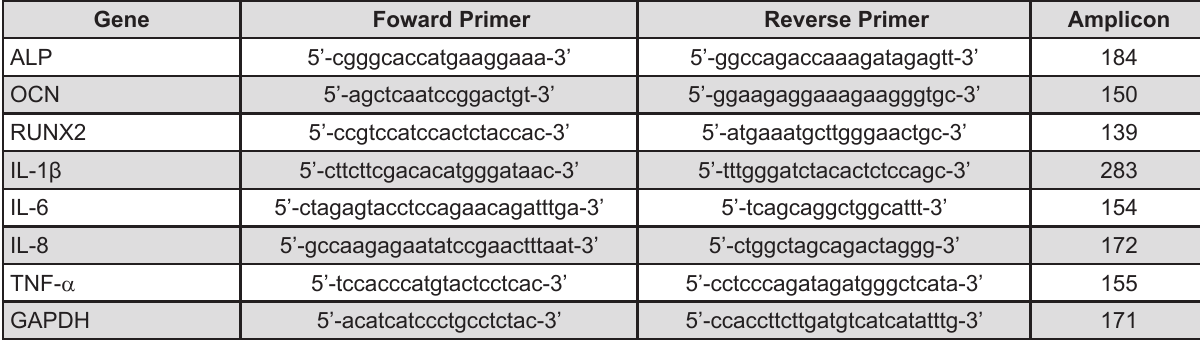
Figure 1- Primers sequence used for amplification in real-time